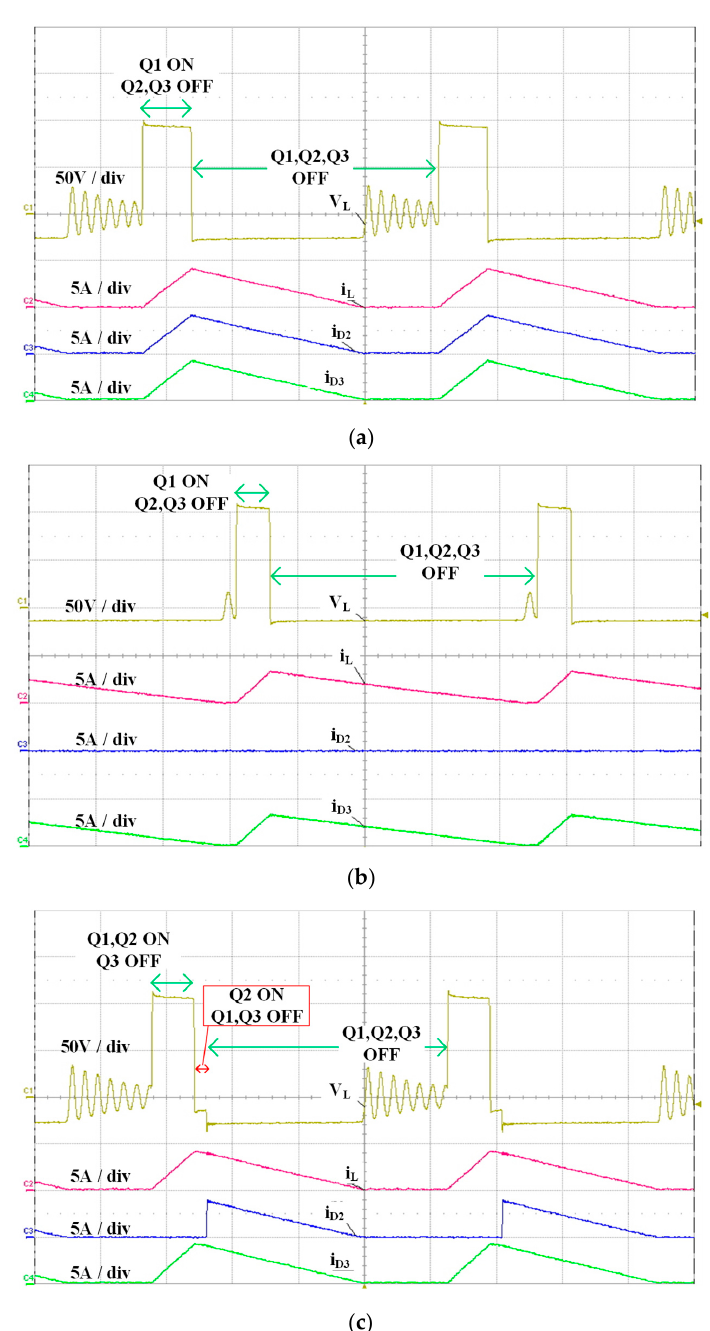
operation mode, are shown in Figure 17. Figure 17a shows the waveforms of the DCC region with 25 V battery pack voltage and 1.5 A charging current. Figure 17b shows the waveforms of the SCC region with 13 V single battery voltage and 1.5 A charging current. In the DCC and SCC regions, only switch Q 1 is activated to control the charging current. Figure 17c shows the waveforms of the HCCCV region with battery voltages, V 1 = 14.4 V and V 2 = 12.3 V, and charging currents, I 1 = 1 A and I 2 = 1.5 A. In this region, switch Q 2 is activated to reduce the charging current for battery B 1 .